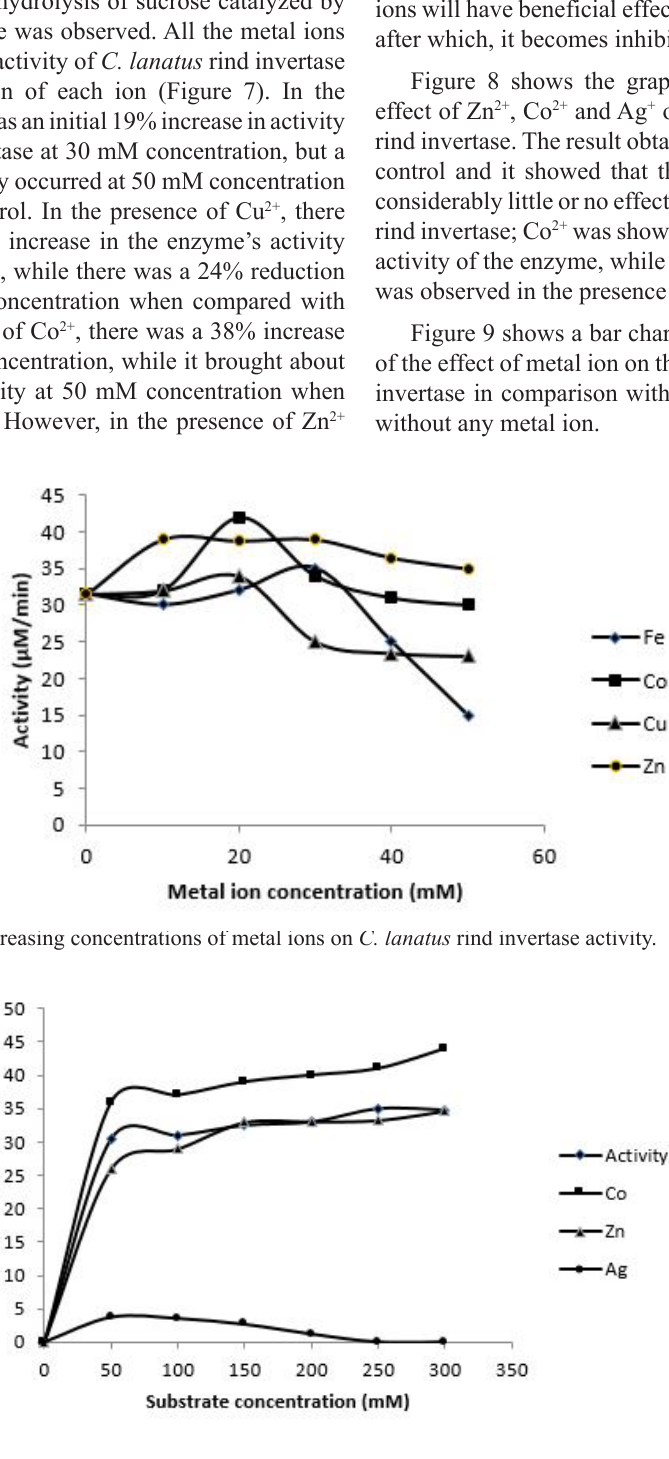
Figure 8: Activity of C.lanatus rind invertase in the presence and absence of Co 2+ , Zn 2+ and Ag +